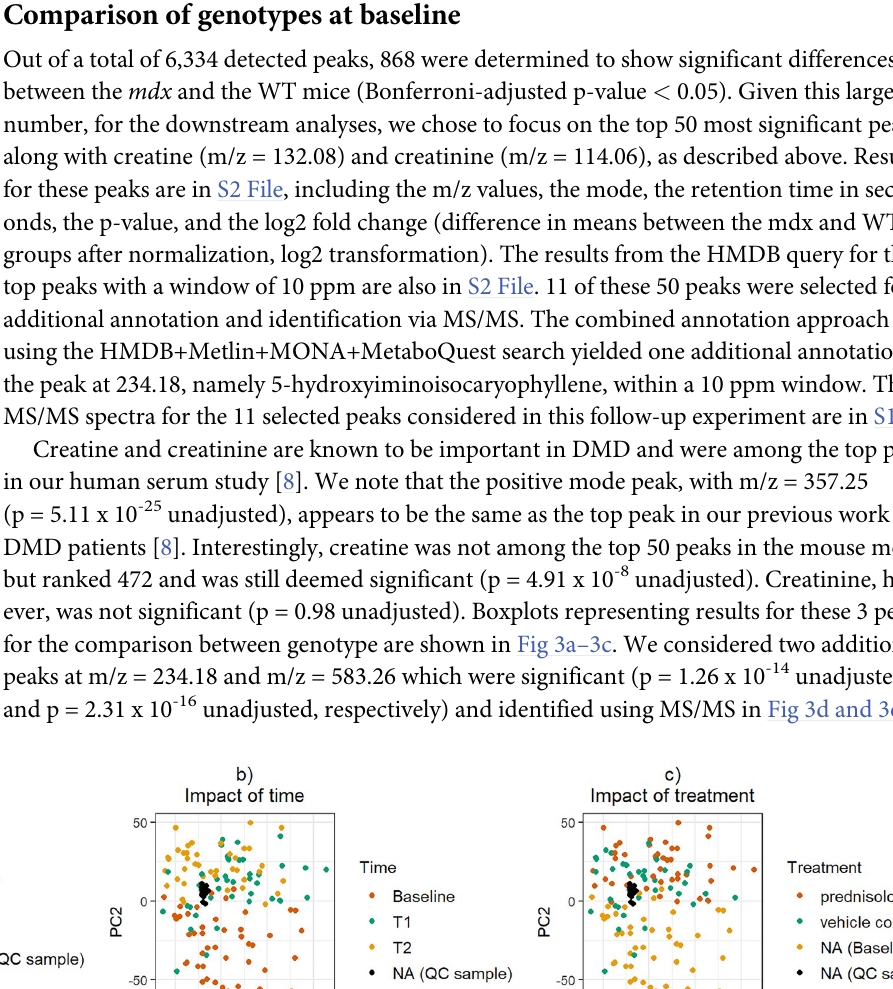
PLOS ONE | https://doi.org/10.1371/journal.pone.0219507 July 16,